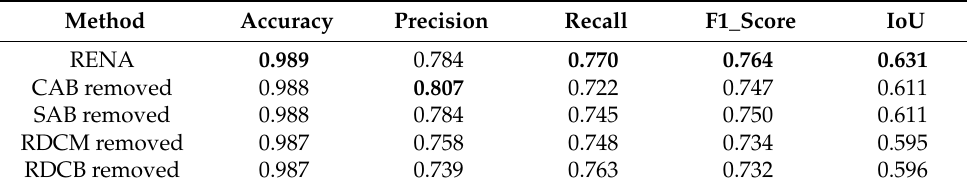
Table 3. Quantitative evaluation results of ablation